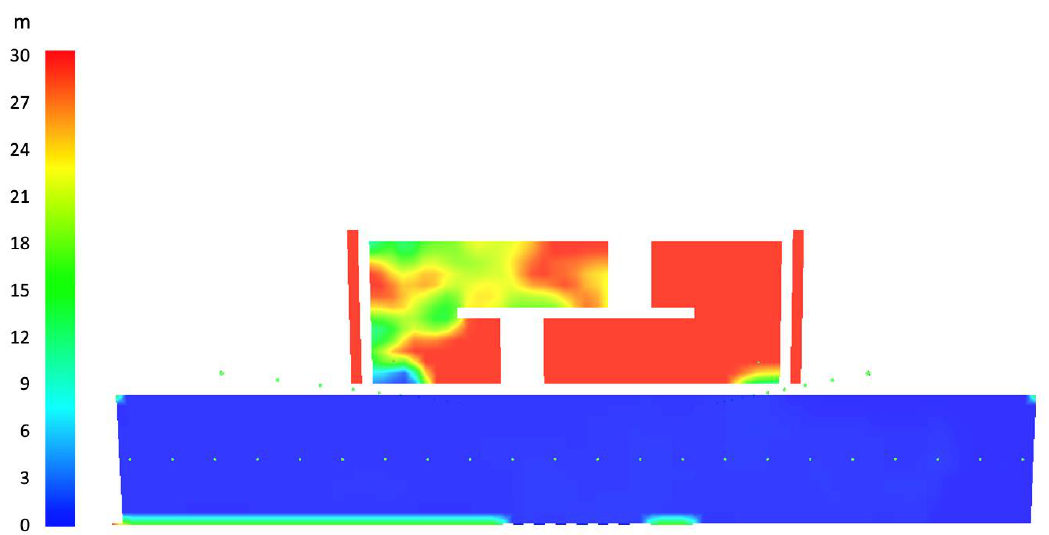
Figure 15. Visibility at 2 m above floor level on the floor of fire origin at 300 s. Toxicity does increase past zero, to the highest amount of all simulations but the results are nowhere near exceeding the FED tenability limit of 0.3, with a maximum recorded value of 0.0012. FED values only begin to increase at 250 s, corresponding to the point when smoke initially enters the stair as per Figure 16.